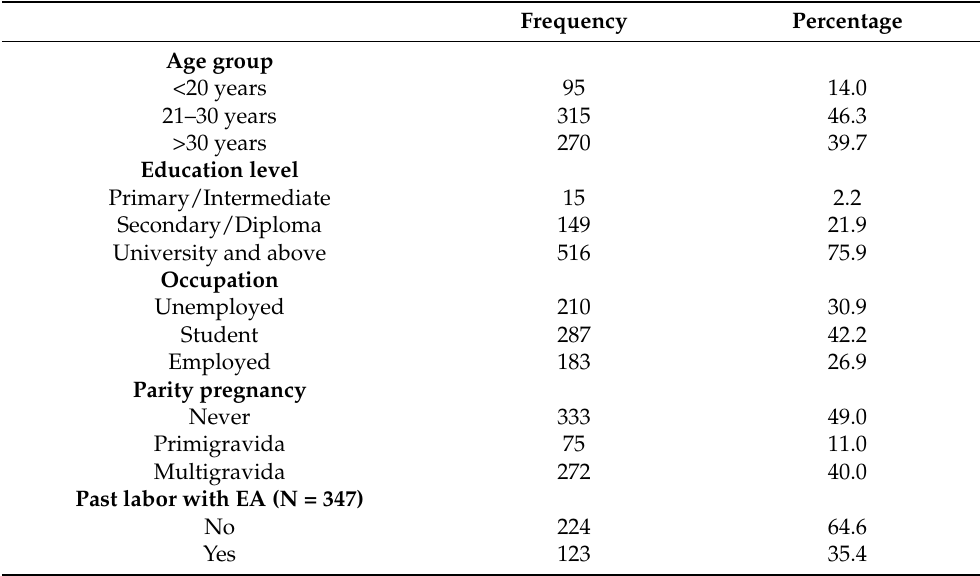
Table 1. Socio-demographic characteristics of the study participants.